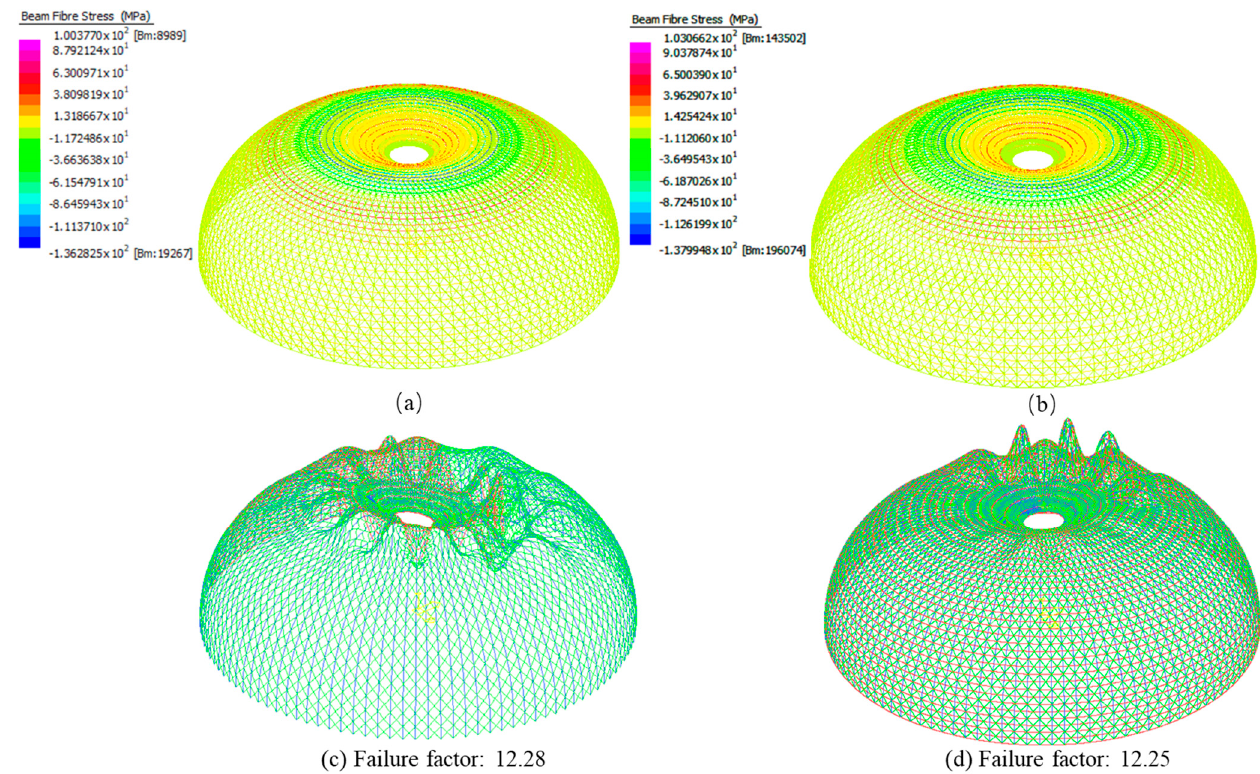
Figure 10. ( a ) Linear analysis of total fiber stress of straight member model under 1.35G; ( b ) nonlinear analysis of total fiber stress of straight member model under 1.35G.